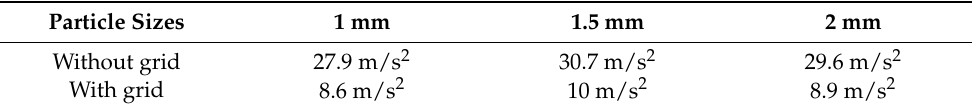
Figure 6. Vibration response of cantilever beam with and without obstacle grid particle dampers at different particle sizes. Table 3. Vibration acceleration response at different particle sizes.